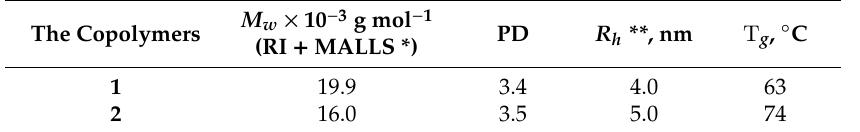
* The increment of the refractive index d n /d c was in the range of 0.056–0.058 mL g − 1 . ** Measurements were carried out in 1 wt% solutions of copolymers in isopropyl alcohol at a temperature of 30 °C. M W : molecular weight and PD: polydispersity.